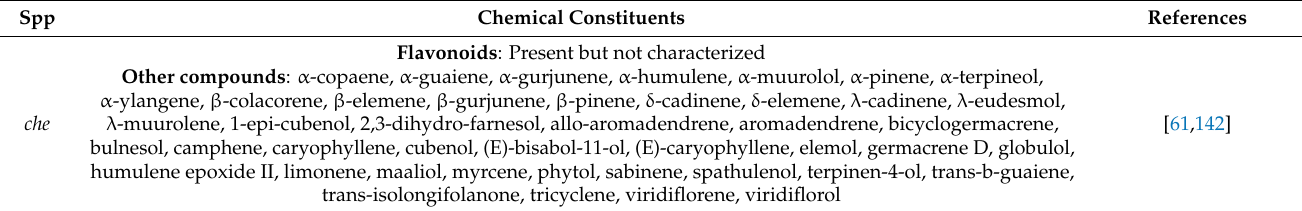
Table 4. Chemical constituents from austral South American Bauhinia . Taxa and compound nomen- clature according to published papers. che — cheilantha ; for — forficata ; hol — holophylla ; mic — microstachya ; ruf — rufa ; ung — ungulata ; uru — uruguayensis